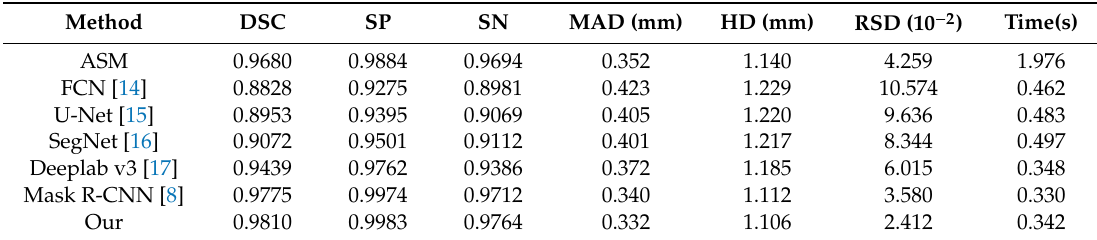
Table 3. Quantitative evaluation of di ff erent